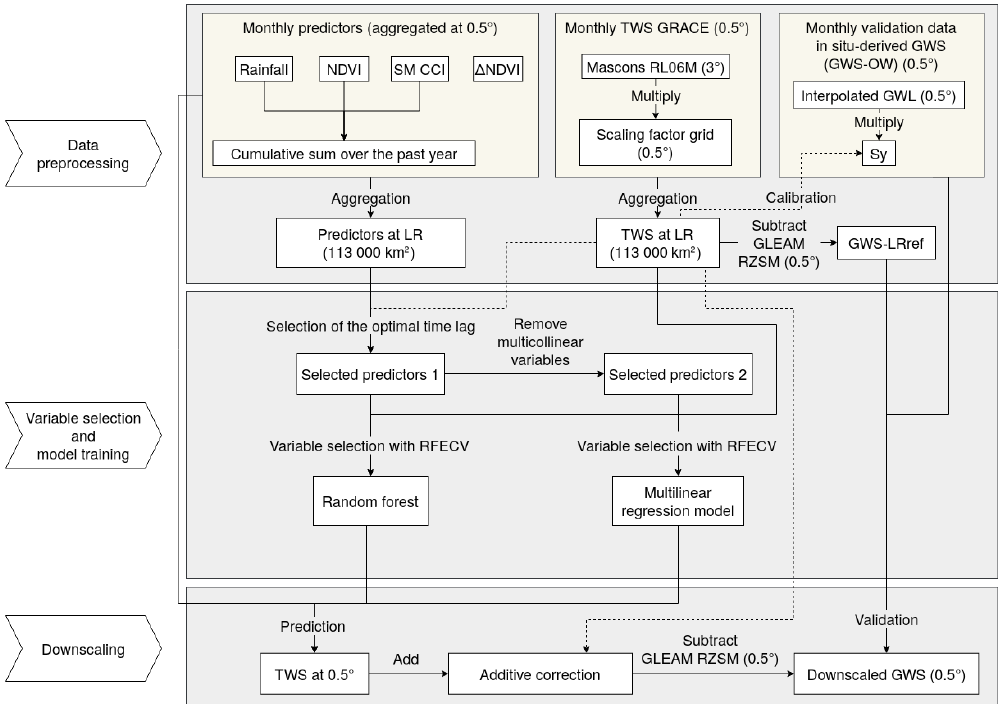
Figure 3. Flowchart of the downscaling method.